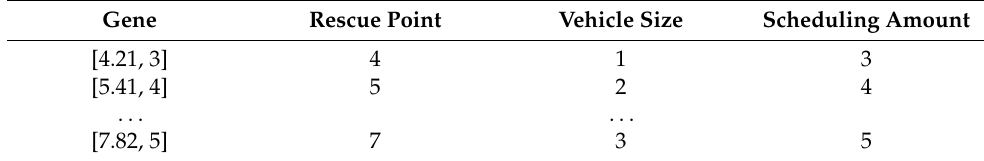
Table 5. Coding operation